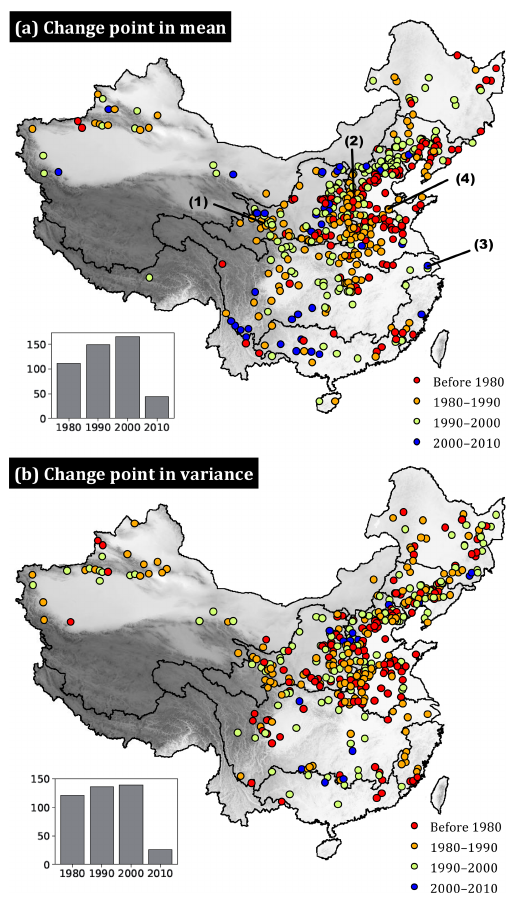
Figure 3. Change points in (a) mean and (b) variance. Color repre- sents the year of the change-point occurrence. The insert plot shows the histogram of the years of the change-point occurrence (the y axis represents the number of change points, while the x axis repre- sents the ending year of a 10-year period; e.g., 1990 actually means 1980–1990). Only stations with results being statistically significant (at the level of 5%) are shown. There are 436 (38%) and 398 (35%) stations with significant change points in mean and in variance, re-